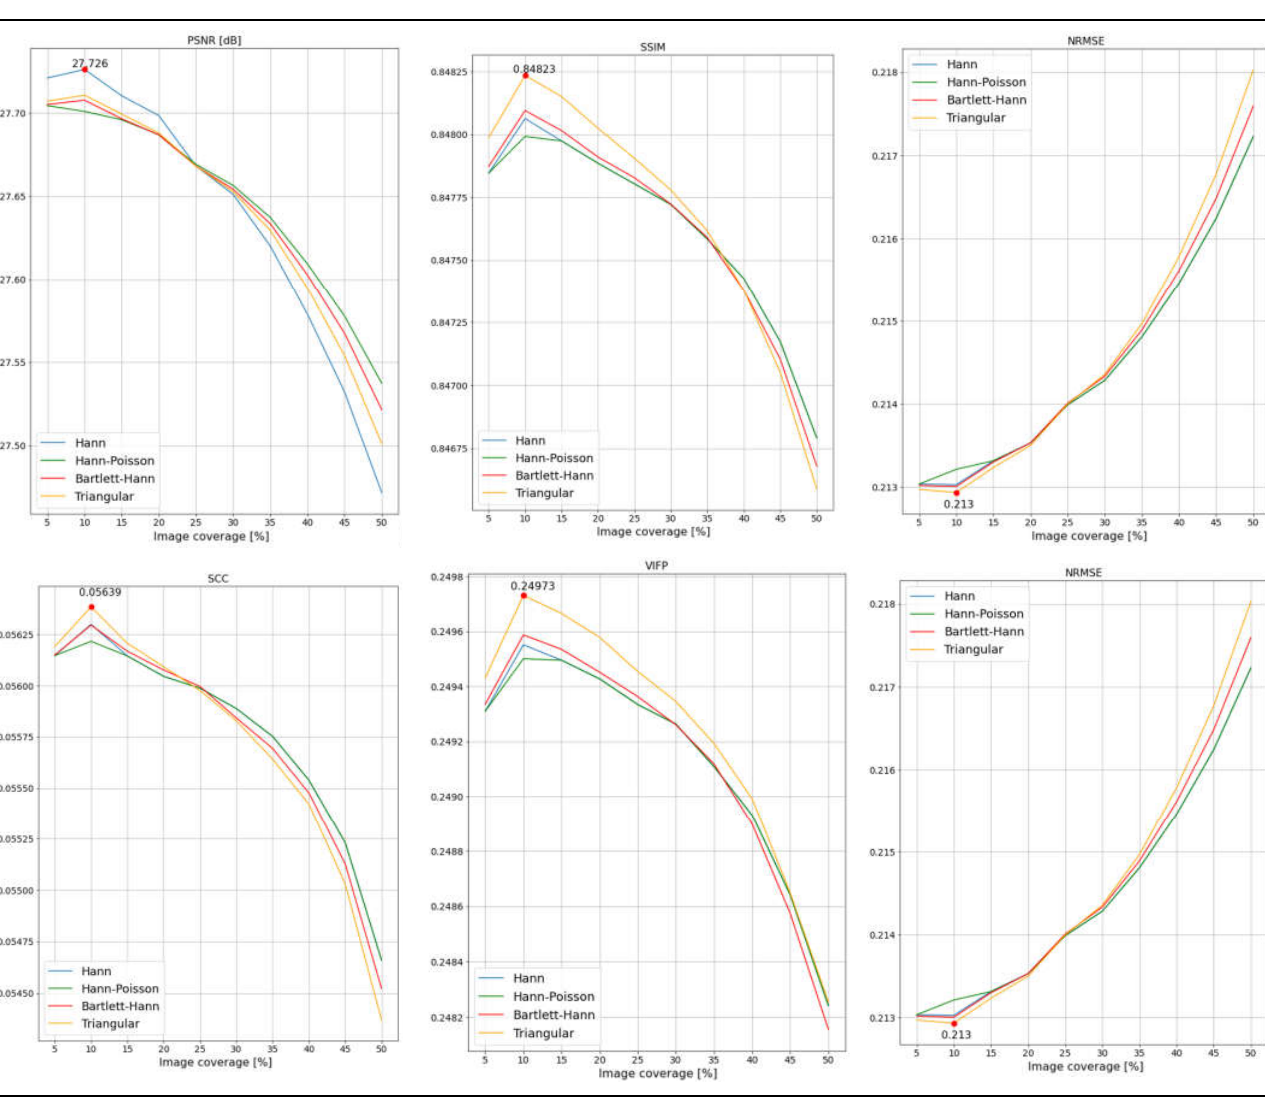
Table A2. Results.